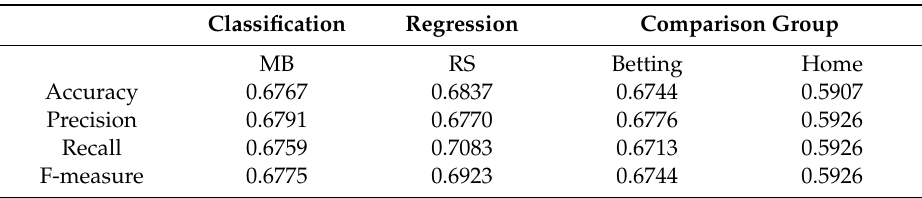
Table 4. Comparison of di ff erent